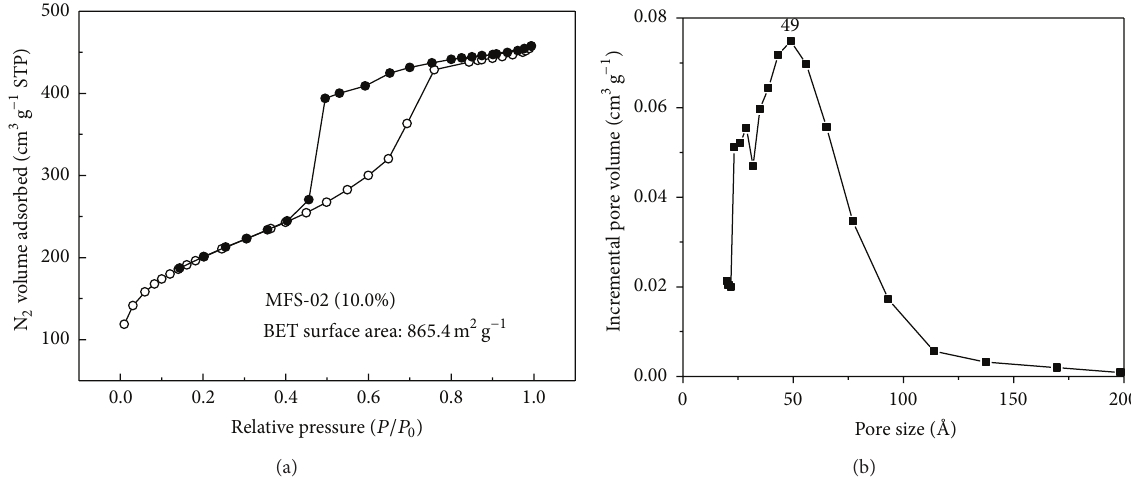
Figure 3: (a) N 2 sorption isotherms of the MFS-02 crystals at 77 K; (b) pore size distribution the MFS-02 crystals from the BJH model. 𝑃 / 𝑃 0 is the ratio of gas pressure ( 𝑃 ) to saturation pressure ( 𝑃 0 = 101.3 Kpa).